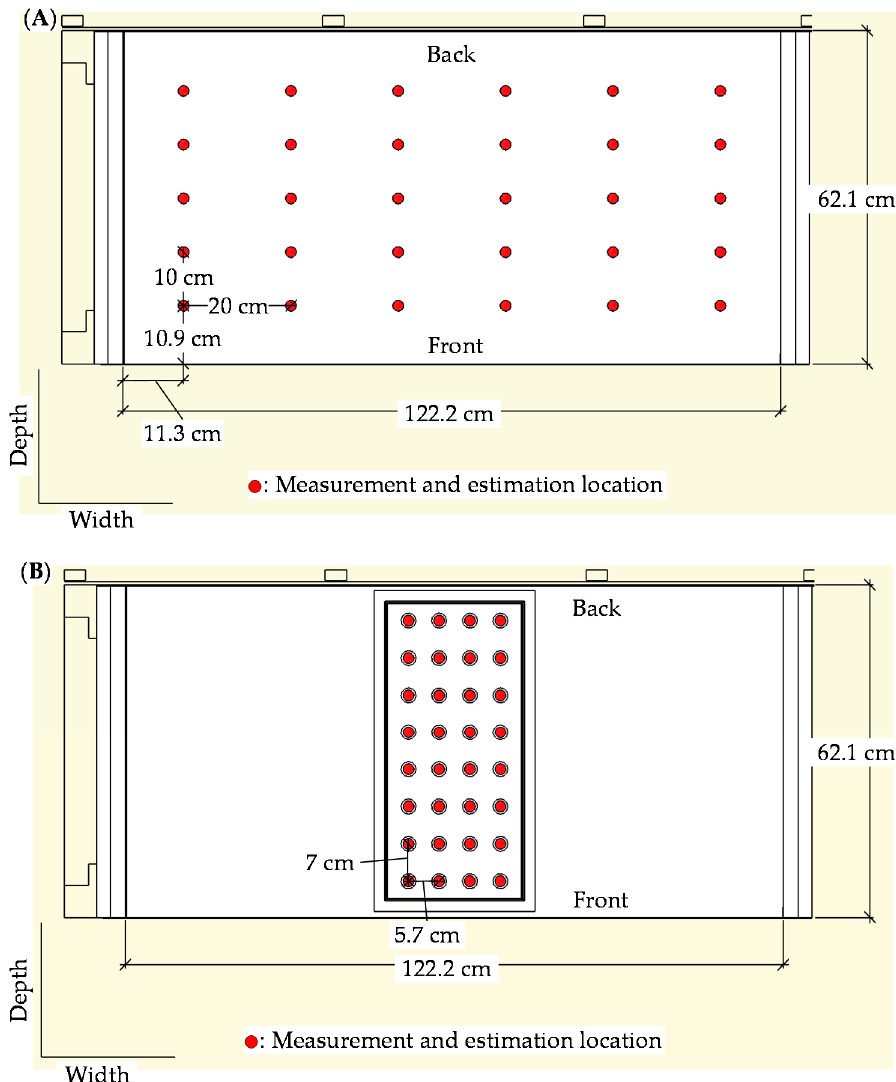
Figure 5. The locations of measurement and estimation of photosynthetic photon flux density (PPFD) at the bottom surface of the cultivation shelf without a container (30 points) ( A ), and on the growing surface (32 points) ( B ). The height of the growing surface was 14.1 cm. The measured and estimated PPFD values were acquired under the conditions that 8 LED lamps with blue and red LED chips (BRLED) were arranged at equal intervals at 41 cm in height, and the radiant flux output was set at the maximum and half values.